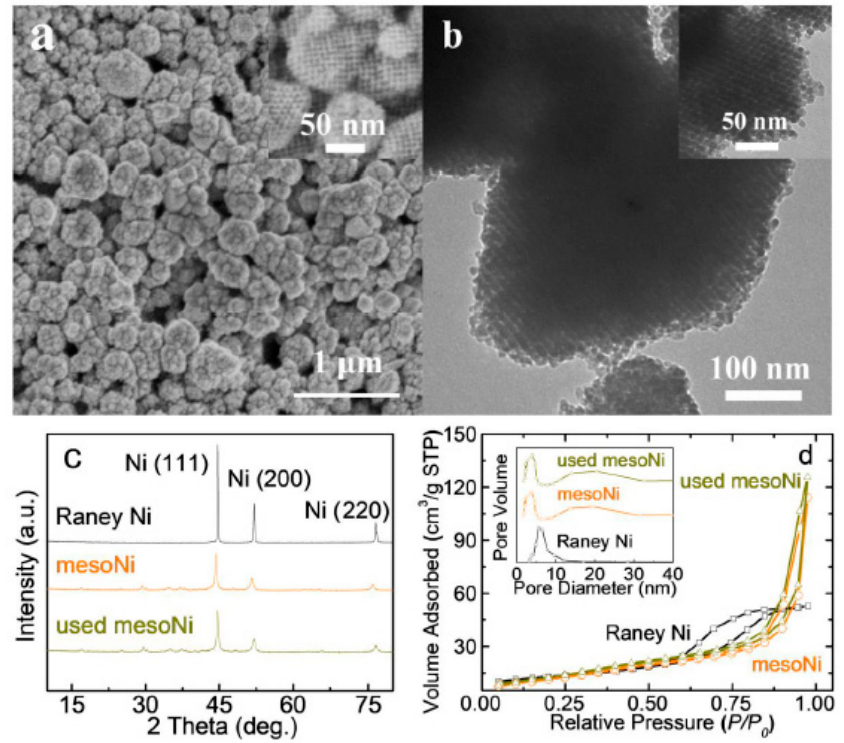
Figure 1. ( a ) Scanning electron microscope (SEM) images and ( b ) transmission electron microscope (TEM) images of ordered mesoporous Ni made with KIT-6 ordered mesoporous silica as a hard template (mesoNi), ( c ) high-angle XRD patterns, and ( d ) related N 2 -sorption characterizations of Raney Ni, mesoNi, and used mesoNi. The insets in (a) and (b) show high resolution images of mesoNi.